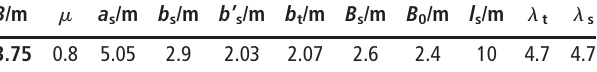
Figure 12 HIL simulation platform Table 4 De fi ning values in